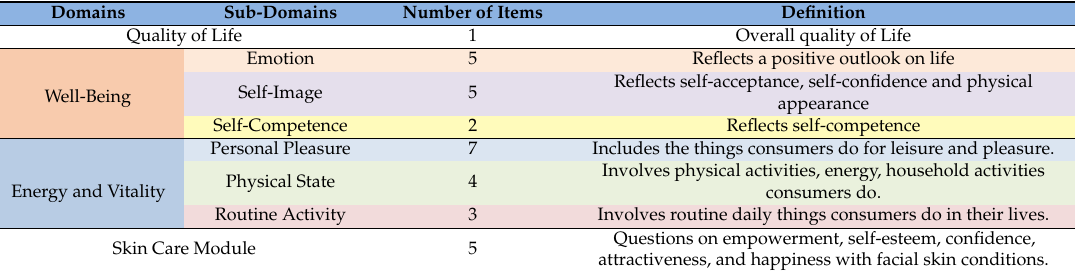
Table 2. Structure of the Farage Quality of Life (FQoL ™ )